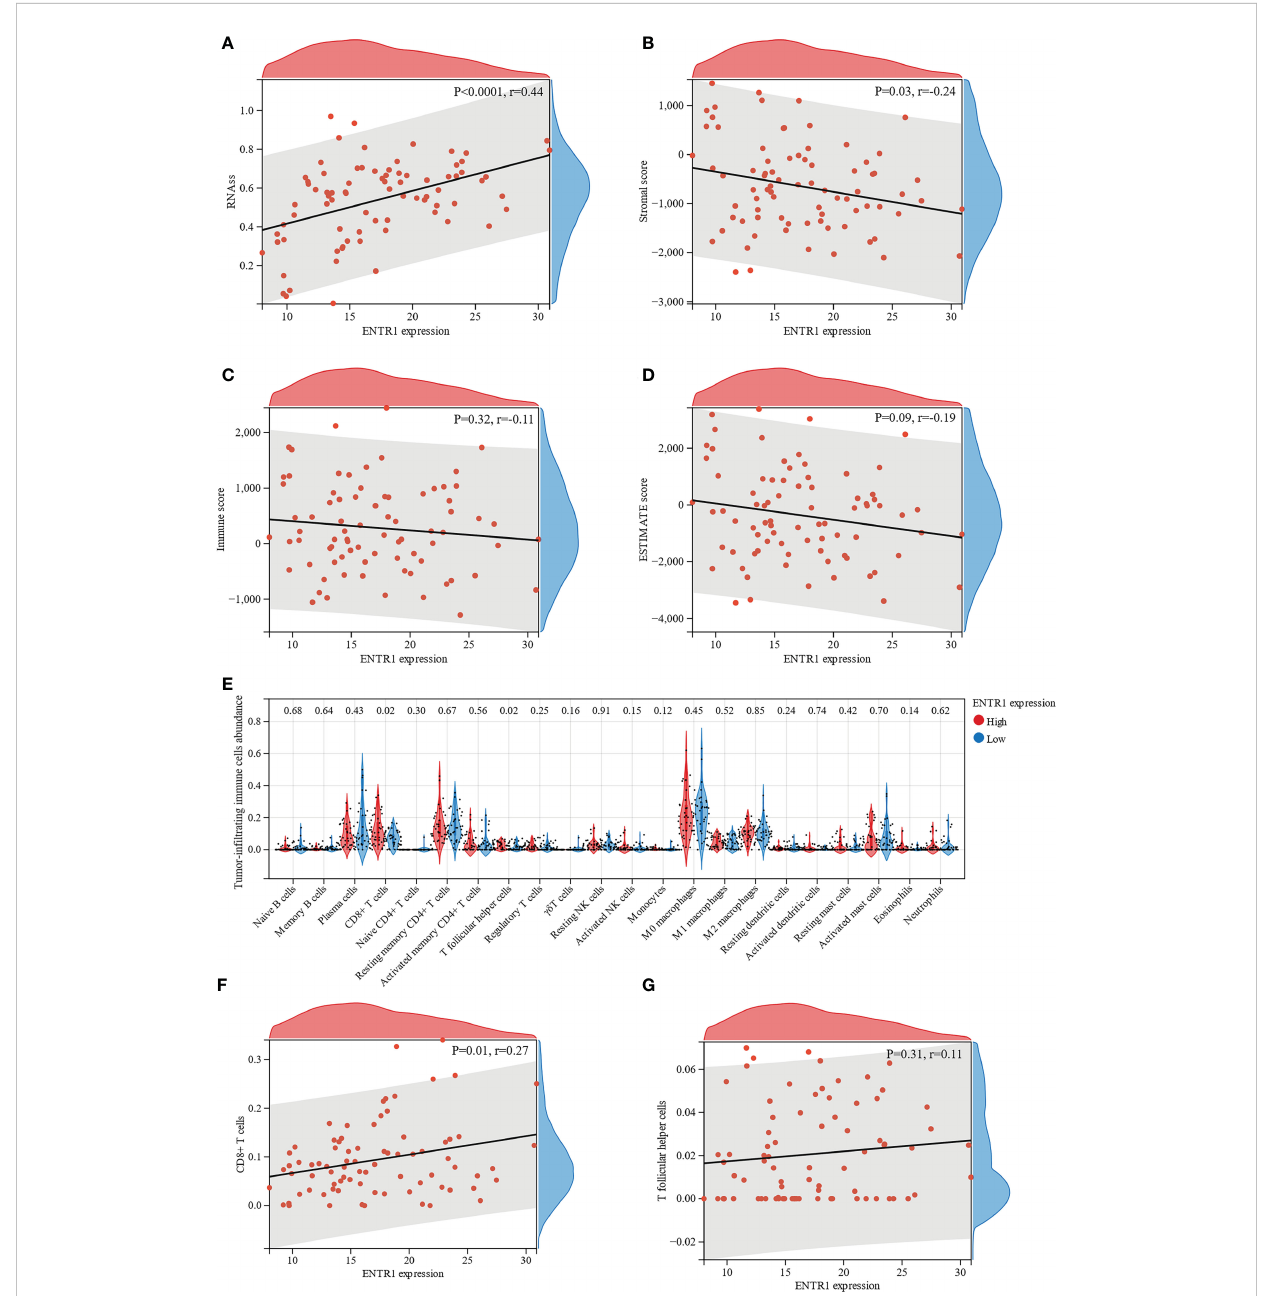
FIGURE 7 Relationship of ENTR1 with cell stemness of MAC and immune in fi ltration. Relationship between ENTR1 expression and (A) the RNA based Stemness Scores (RNAss), (B) stromal scores, (C) immune scores, and (D) ESTIMATE scores. (E) Immune in fi ltration analysis reveals association of ENTR1 expression and 22 types of tumor-in fi ltrating immune cells. Relationship between ENTR1 expression and (F) CD8+ T cells and (G) T follicular helper